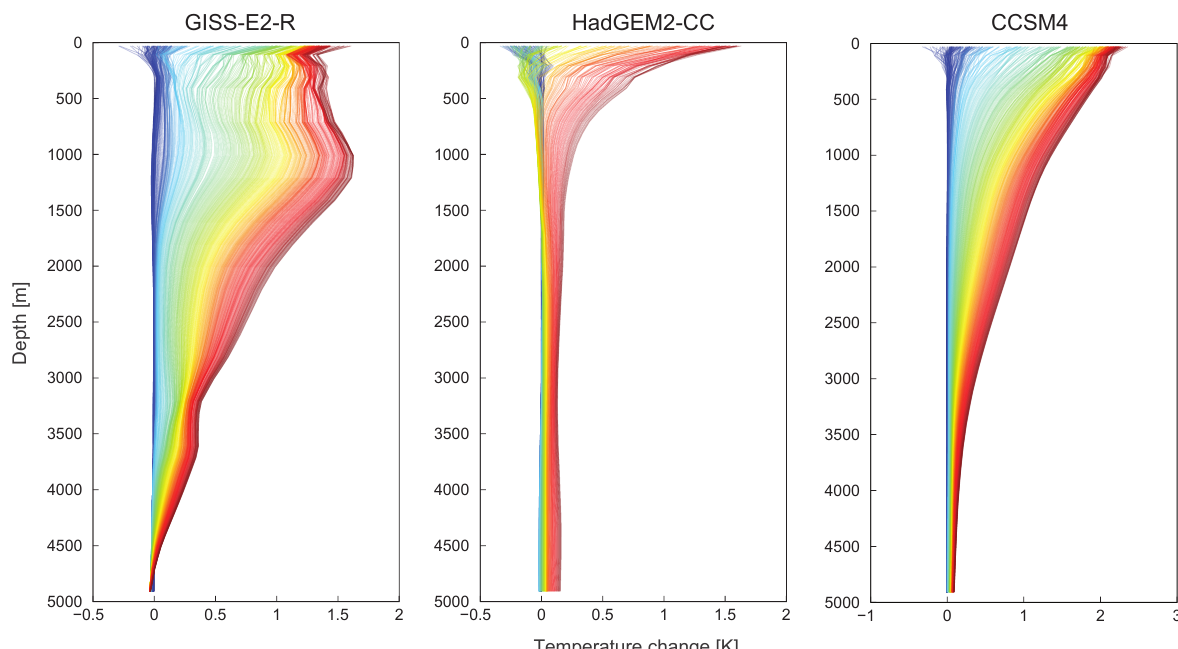
Figure A2. Annual RCP4.5 ocean warming anomalies for the CMIP5 models GISS-E2-R (1850–2300), HadGEM2-CC (1850–2100), and CCSM (1850–2300), relative to 1850 and globally averaged. Annual potential ocean temperature anomaly profiles are shown as dark blue in 1850 via green and yellow to red for the last year of the reference data.